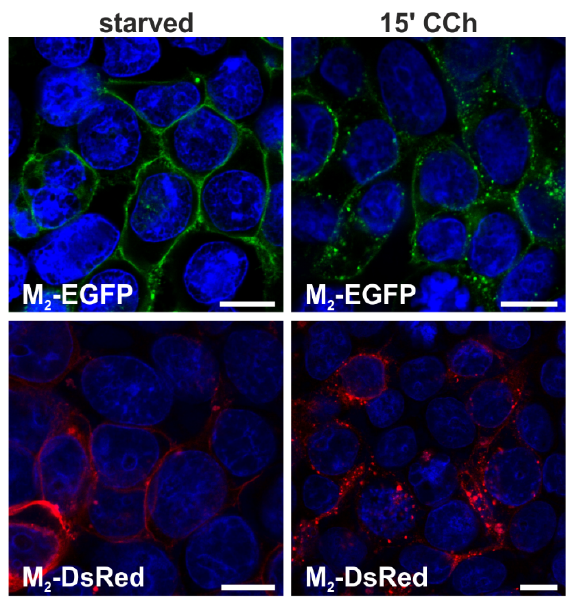
Figure 1. CCh stimulation induces internalization of M 2 -EGFP and M 2 -DsRed in HEK 293T cells. HEK 293T cells were transiently transfected with plasmids coding for M 2 -EGFP or M 2 -DsRed. The cells were starved for 18 h in serum-free medium and either left untreated or stimulated with 1 mM CCh for 15 min. Cells were fixed and the nuclei stained with DAPI (shown in blue). Scale bars: 10 μ